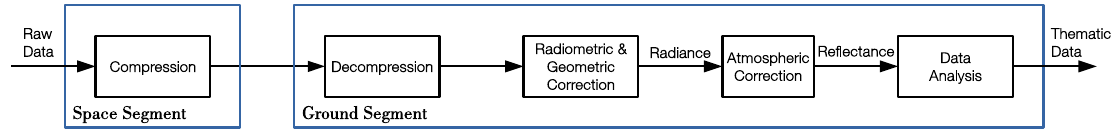
Figure 2. Hyperspectral data analysis chain. The compression stage is mandatory in the space